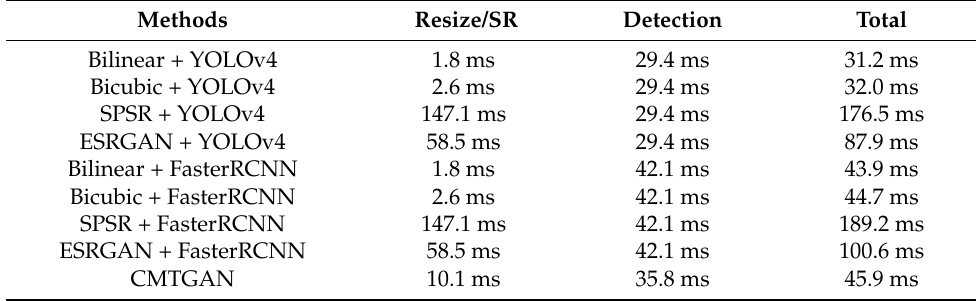
Table 7. Inference time of object